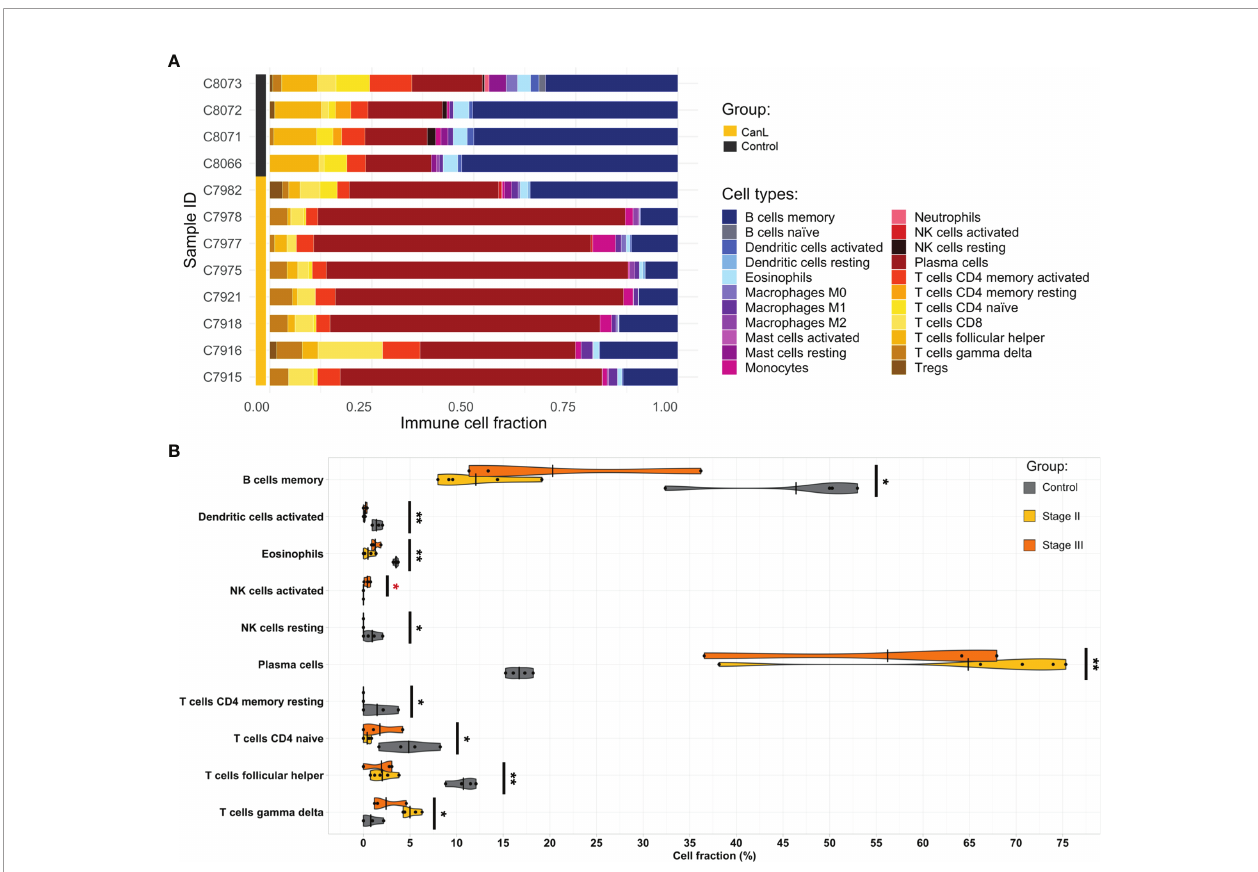
FIGURE 2 | The landscape of the cell composition in the lymph node aspirates based on their RNA-seq data. (A) Relative proportion of each immune cell type across samples was inferred by CIBERSORTx. (B) Violin and dot plots of immune cell populations from deconvolution analysis that displayed signi fi cant differences between groups, as estimated by Wilcoxon test. Signi fi cant differences between clinical stages II and III are highlighted in red. *p-value <0.05, **p-value <0.01, ***p- value